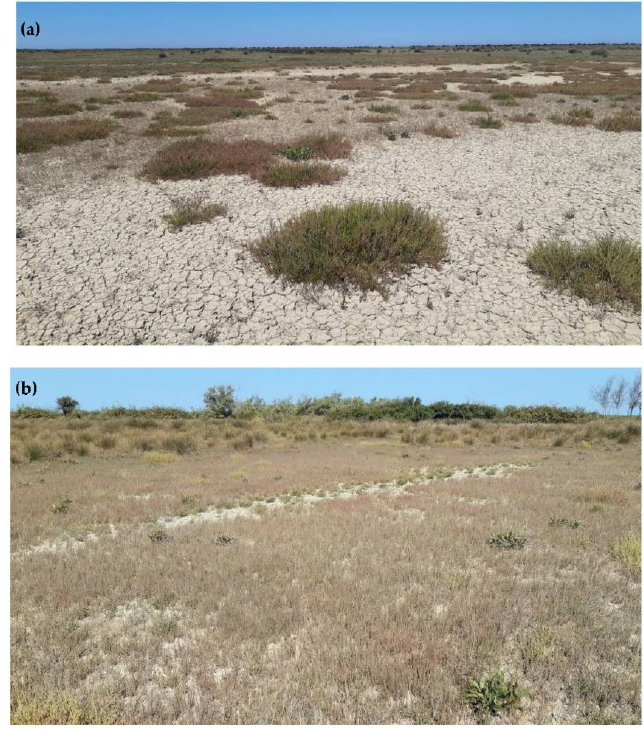
Figure 2. Salt marsh vegetation of Tyrrhenian coasts (Italy): ( a ) Salicornia perennis communities; ( b ) Salicornia perennans communities. Photo credit: Andrea Bertacchi. The species and subspecies Halimione portulacoides , Salicornia perennans